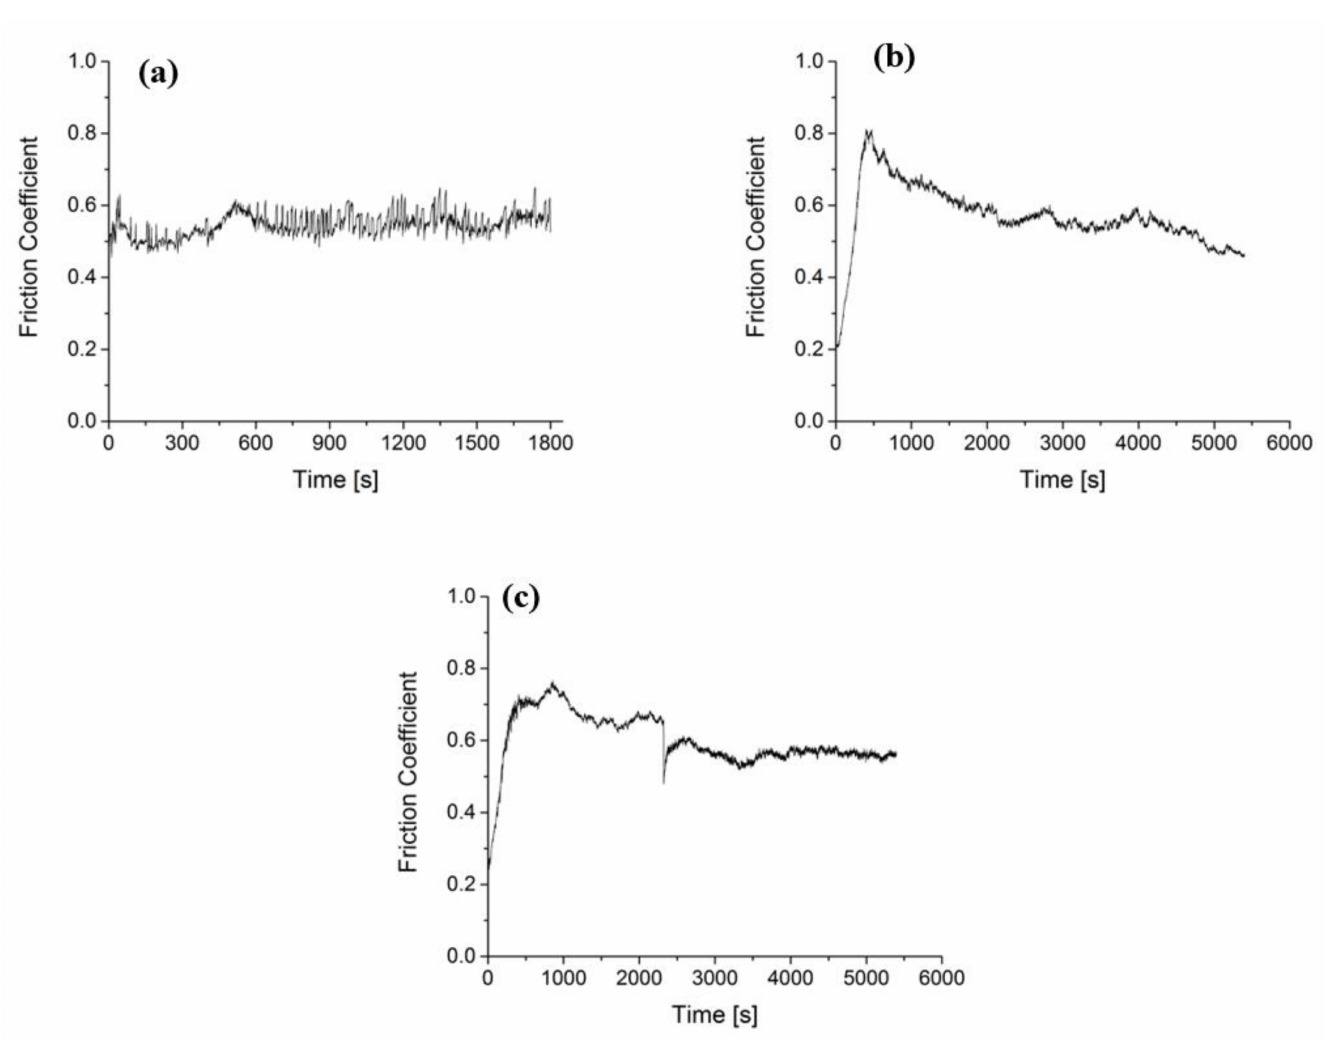
Figure 5. Friction traces that were obtained from pairings with ( a ) uncoated martensitic stainless steel; ( b ) WC-CoCr coating; and ( c ) WC-FeCrAlY